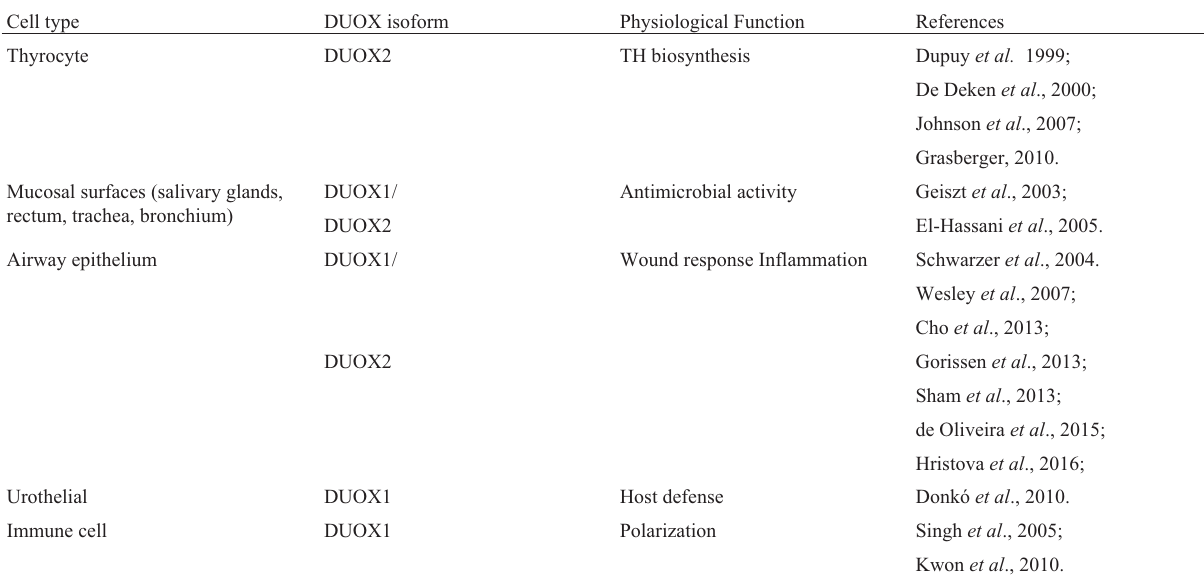
Table 1 - DUOXs physiological functions in mammals according to cell-type